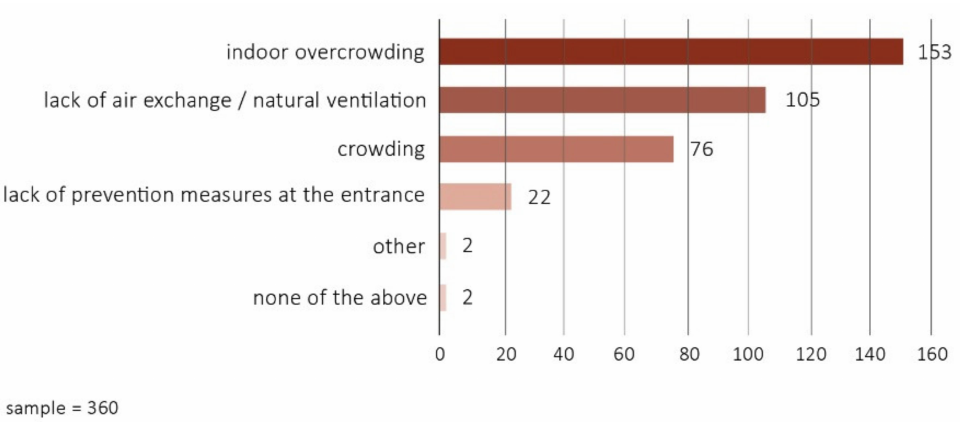
Figure 10. Graphics illustrating the users’ opinions about the most worrying conditions in an indoor environment (online questionnaire). Own